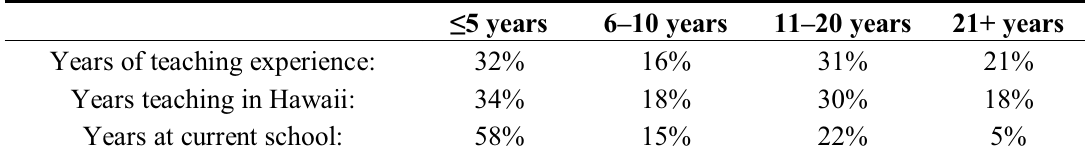
Table 1. Educate to Eradicate partner teacher professional experience.